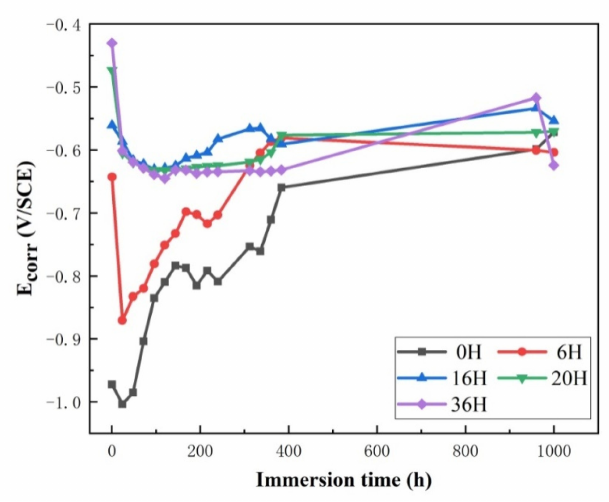
Figure 6. Open circuit potential of WB zinc − based coatings after storage for different times (0H, 6H, 16H, 20H,